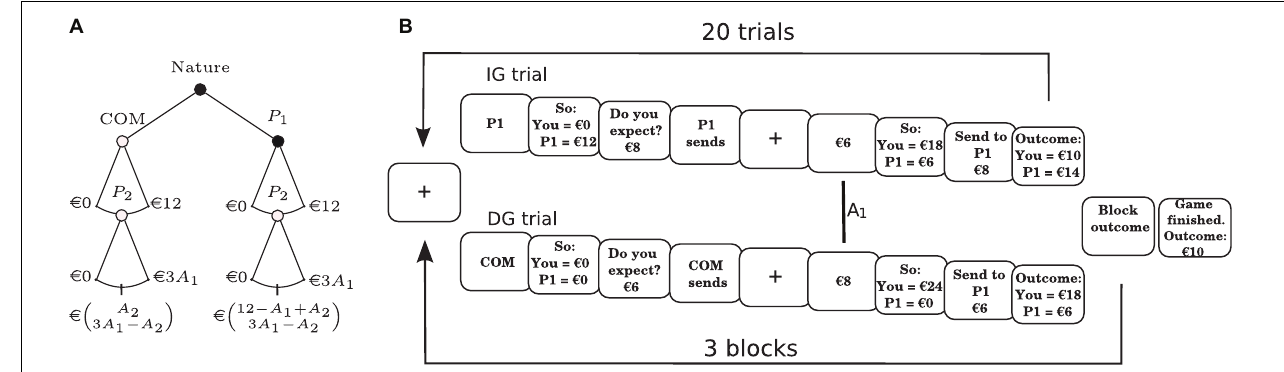
FIGURE 1 | Experimental protocol. (A) Behavioral protocol. Schematic of the Dictator/Investment game (DIG) used here. Whether the subject faced a Dictator (DG; open node) or an Investment (IG; closed node) condition was decided randomly with a probability of 0.5 for each. Subjects always played as P 2 . The payoff matrix is at the bottom of the tree, with payoffs for P 1 and P 2 shown in the first and second row, respectively. (B) Flow of the game. Subjects played a total of 60 trials (in 3 blocks of 20 trials), consisting of 30 trials under the IG conditions (upper flow) and 30 trials under the DG conditions (lower flow). Trigger (vertical line) marks the moment when the subject was notified that an allocation (A 1 ) had been made. COM: computer; P1: player 1 (the trustor); P2: player 2 (the trustee).